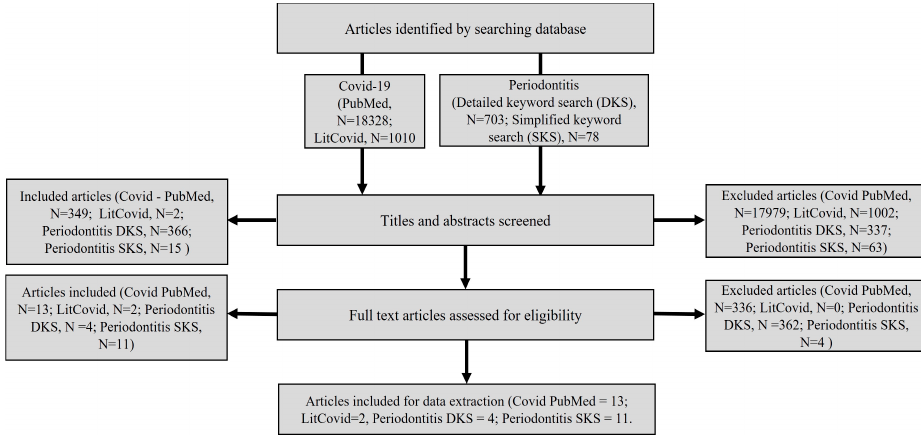
Figure 2. Flowchart of search strategy.